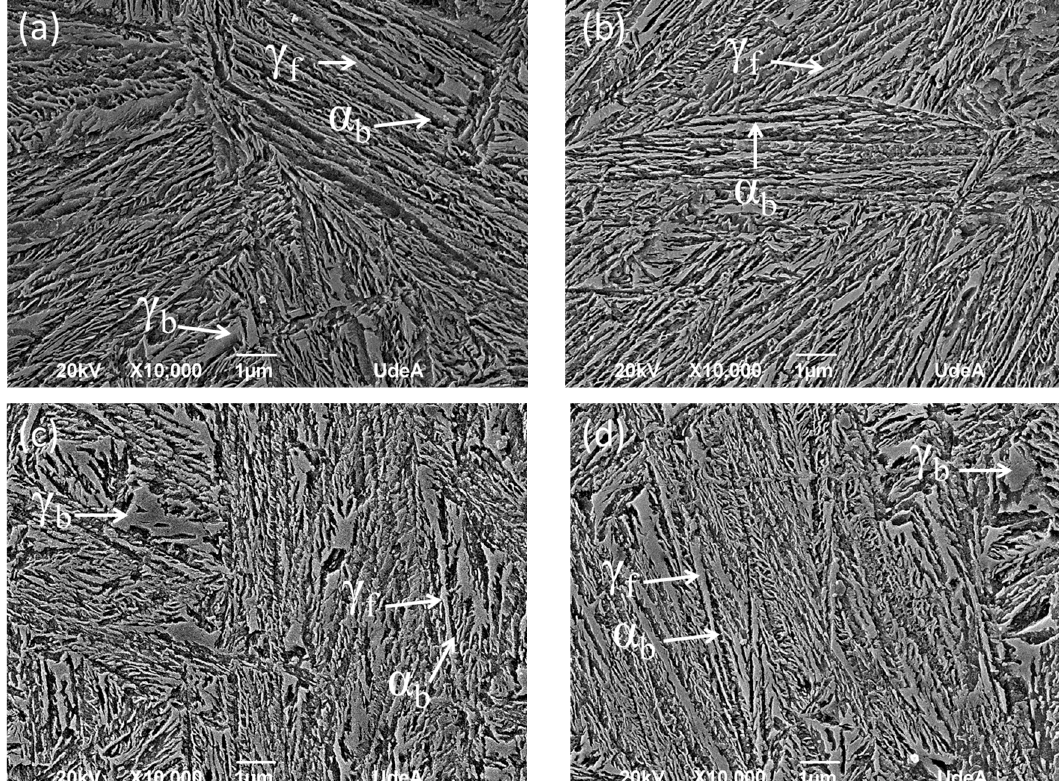
Figure 3. SE ‐ SEM micrographs of samples isothermally treated at: ( a ) 250 °C ‐ 4 h, ( b ) 250 °C ‐ 8 h, ( c ) Figure 3. SE-SEM micrographs of samples isothermally treated at: ( a ) 250 ◦ C-4 h, ( b ) 250 ◦ C-8 h, 300 °C ‐ 1 h, and ( d ) 300 °C ‐ 2 h. γ f : austenite films, γ b : austenite blocks, α b : bainitic ferrite. ( c ) 300 ◦ C-1 h, and ( d ) 300 ◦ C-2 h. γ f : austenite films, γ b : austenite blocks, α b : bainitic